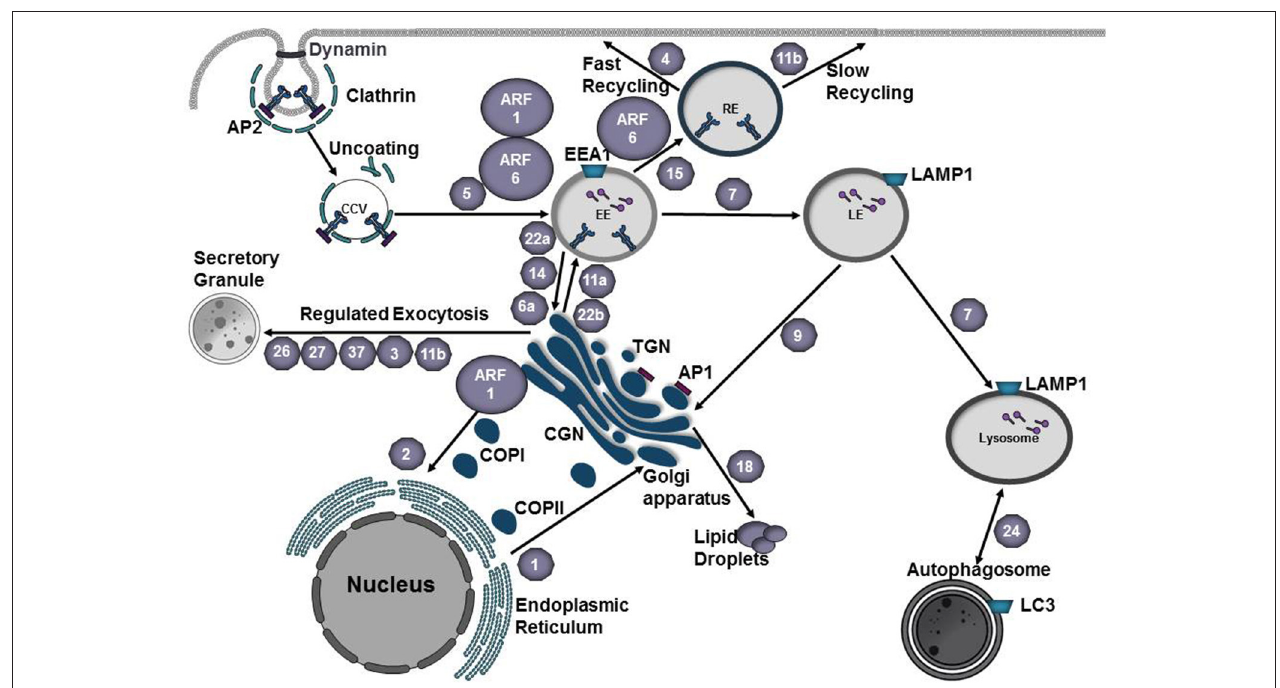
FIGURE 1 | Vesicle trafficking pathways of the endocytic and secretory pathways. Small GTPases of the Arf family recruit protein coats to the donor membrane to initiate vesicle budding. Clathrin coated vesicles are generated at the plasma membrane or trans- Golgi network (TGN) and mediate cargo transport to endosomes. Adaptor proteins, such as AP1 and AP3, recognize signal sequences in the C-terminal tails of transmembrane proteins and participate in cargo selection. Coat complex protein I (COPI) and coat complex protein II (COPII) mediate transport from the Golgi to the endoplasmic reticulum (ER) or from the ER to the Golgi, respectively. At the plasma membrane, vesicle scission is mediated by dynamin and vesicles are subsequently transported to their destination along cytoskeletal tracks. Rab GTPases (gray hexagons) play a key role in regulating vesicle transport along the endocytic and secretory pathways. Rab5 mediates fusion of endocytic vesicles to form the early endosome (EE). Maturation into a late endosome (LE) requires Rab conversion from Rab5 to Rab7. Cargo destined for degradation undergoes fusion with lysosomes. Rab24 mediates formation of autophagosomes, which can subsequently fuse with lysosomes to create autolysosomes. Traffic between EE and recycling endosome (RE) is mediated by Rab15. Rab4 and Rab11b regulate fast and slow recycling, respectively. Rab1 mediates ER-Golgi traffic whereas Rab2 regulates retrograde traffic from the Golgi-ER. Regulated exocytosis by secretory granules involves Rab26, Rab27, Rab37, Rab3, or Rab11b. Transport between the EE and Golgi or the LE and Golgi is mediated by Rab22a, Rab14, Rab6a, or Rab9, respectively. Cargo from the TGN is transported to the plasma membrane via fusion with EEs and this process is mediated by Rab22b or Rab11a. Rab18 regulates the formation of lipid droplets. EE early endosome, LE late endosome, RE recycling endosome TGN trans -Golgi Network, CGN cis -Golgi Network, COPI coat protein I, COPII coat protein II, CCV clathrin-coated vesicle, AP1 adaptor protein 1, AP2 adaptor protein